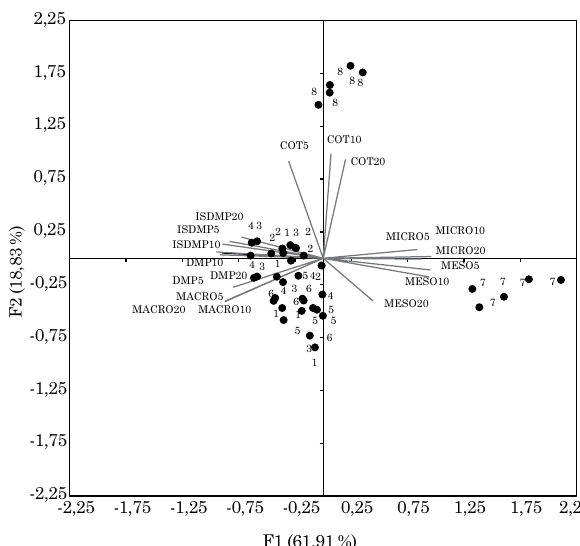
Figura 3. Diagrama de ordenação produzido por análise de componentes principais dos dados coletados. 1 = testemunha, 2 = aveia-preta, 3 = centeio, 4 = nabo-forrageiro, 5 = aveia + nabo, 6 = centeio + nabo, 7 = convencional, 8 = mata. COT: carbono orgânico total, micro: microagregados, meso: mesoagregados, macro: macroagregados, dmP: diâmetro médio ponderado de agregados e iSdmP: índice de